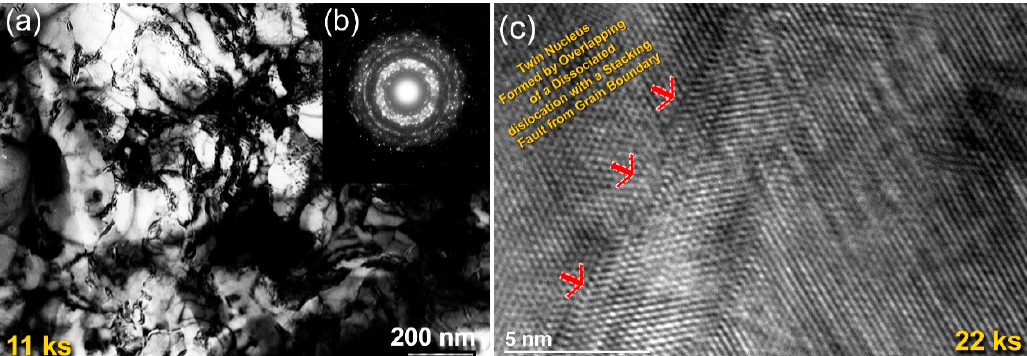
Figure 1. X-ray diffraction (XRD) patterns of hcp-Zr metallic powder that were high-energy ball- milled for ( a ) 0 ks, ( b ) 22 ks, ( c ) 43 ks, ( d ) 86 ks, and ( e ) 259 ks of the reactive ball milling (RBM) time, ( f ) XRD pattern of the spark plasma sintered (SPS) 259 ks-powders.